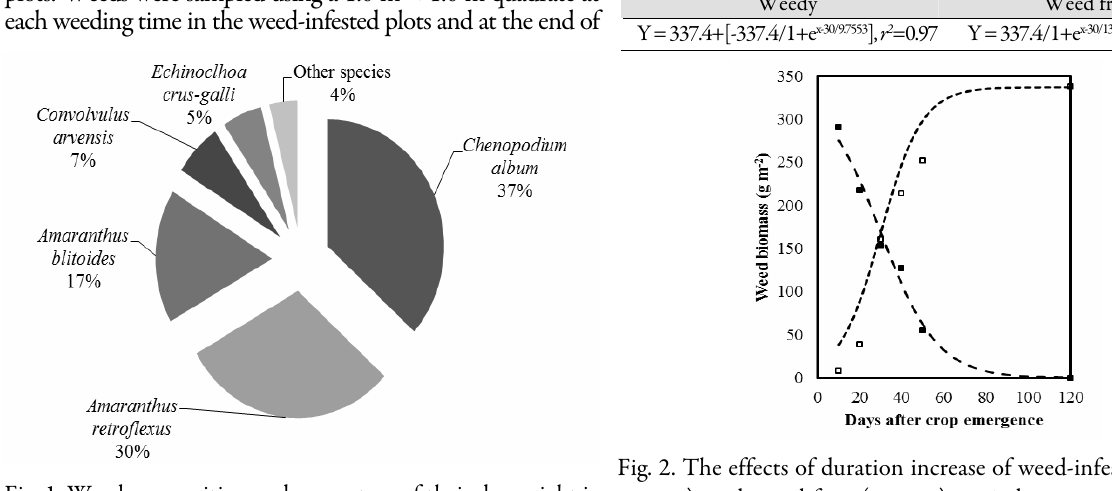
Fig. 1. Weed composition and percentage of their dry weight in full season weed-infested treatment at the crop harvest